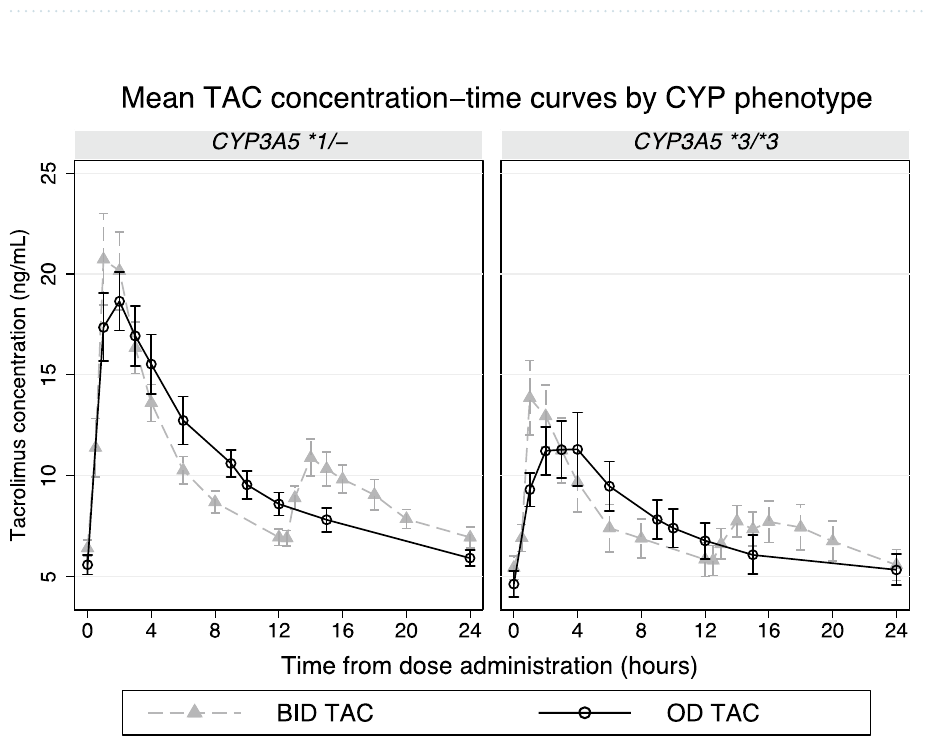
Table 5. AUC 0-24 and C trough with GMR (90%CI) for the OD versus the BD regimen, by CYP3A5 expression.